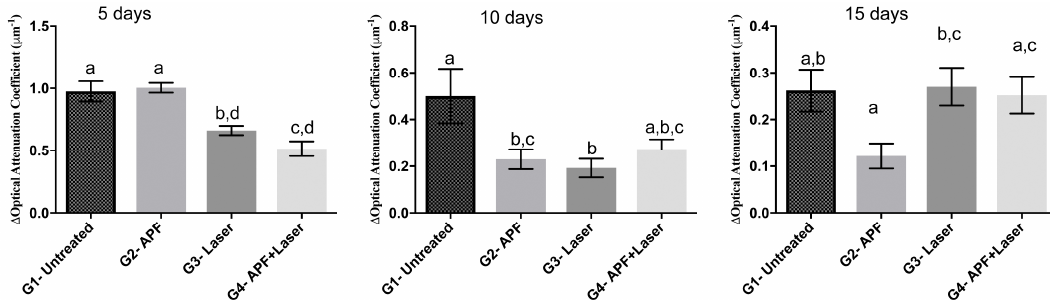
Figure 6. Average of optical attenuation coefficient of all experimental groups 5 days, 10 days, and 15 days after submission to an abrasive/erosive cycling. Bars denote standard error. Distinct letters indicate statistically significant differences ( p < 0.05) according to Tukey’s test.